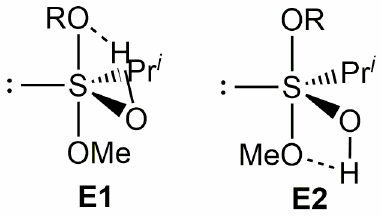
Figure 4. Gibbs free energy profile for reaction path 1; continuous lines correspond to the departure from the apical position of EtOH (blue) and MeOH (red), respectively; the dashed line corresponds to the departure of EtOH from the equatorial position (green) and the violet line corresponds to the substitution of EtOH mediated by (H 2 O) 2 ; descriptions of stationary points are in the color of the corresponding line for clarity.